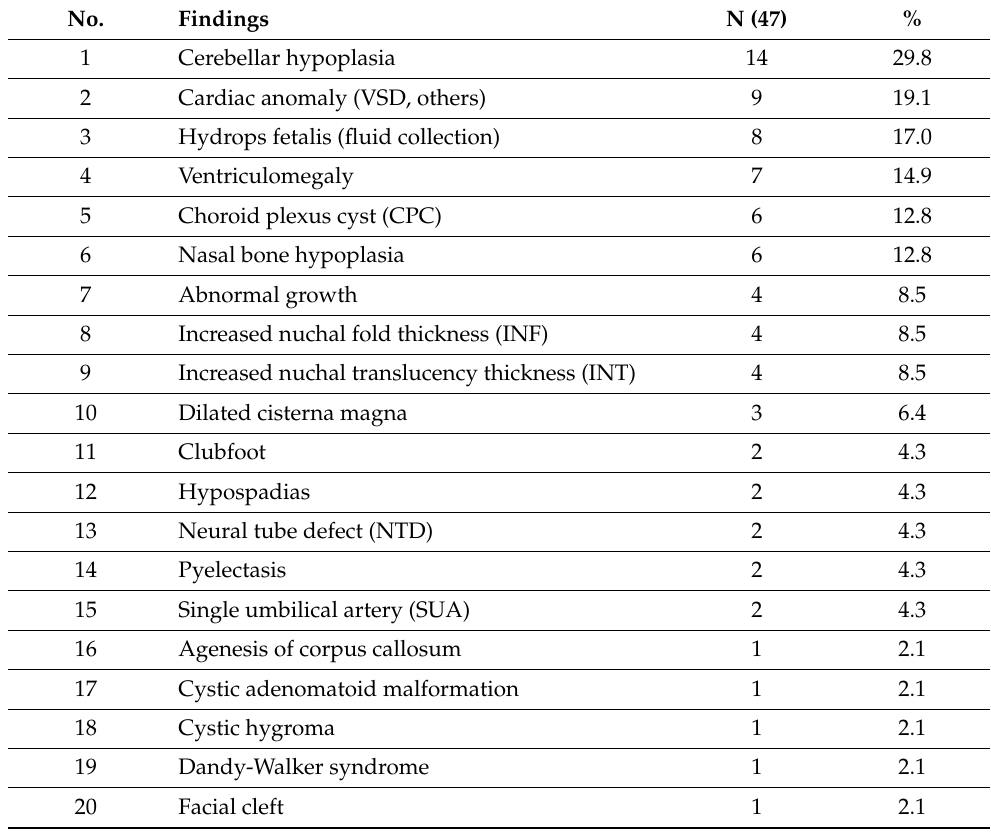
Table 1. Sonographic features of 47 fetuses with Cri-du-Chat syndrome